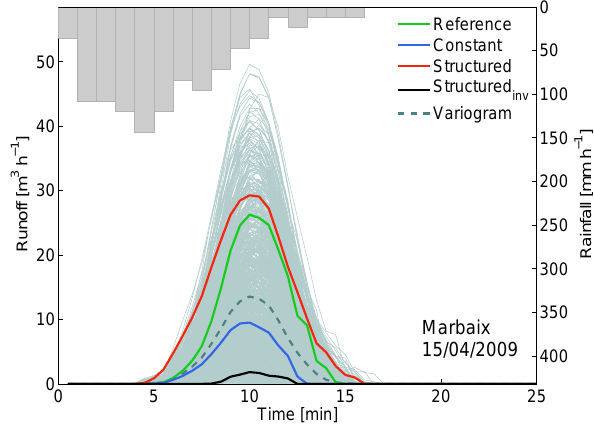
Fig. 7. Hydrographs from hydrologic simulation using the an- tecedent soil moisture maps from scenarios 1 to 4 and 6 for the field campaign in Marbaix, 15 April 2009. The average Variogram hydrograph is depicted in a dashed line on top of the 1000 hydro- graphs from the simulated antecedent soil moisture